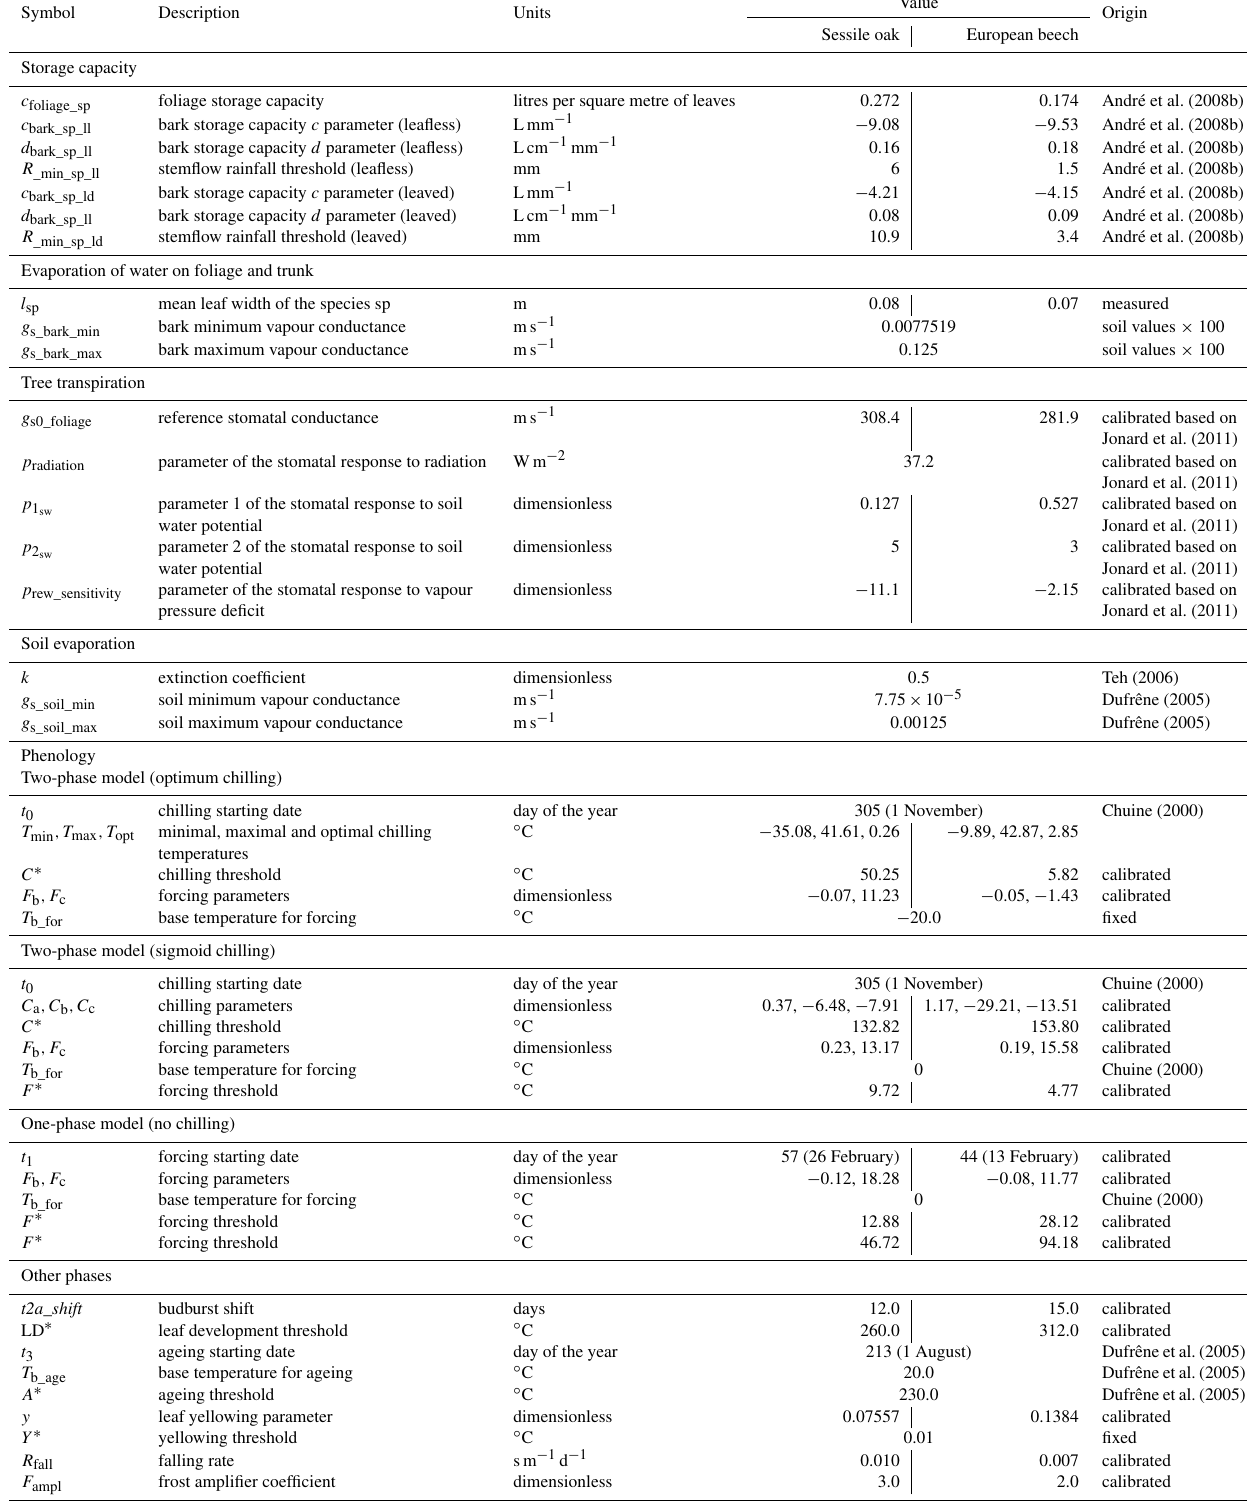
Table 1. Description of the different module parameters for sessile oak and European beech and origin of their value. Symbol